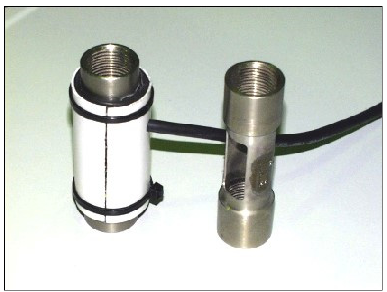
Figure 11. A load cell was purposely designed to measure simulated braking and tractive forces.